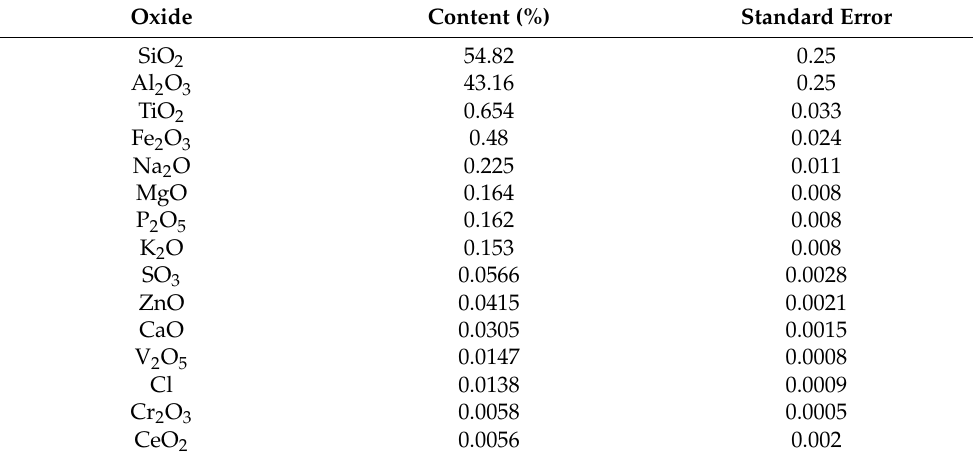
Figure A2. XRD patterns of Raw-Ka, Ka-400 °C, Ka-500 °C, Ka-550 °C, Ka-600 °C, Ka-700 °C and Ka-800 °C . Table A1. XRF analysis of the Raw-Ka sample.